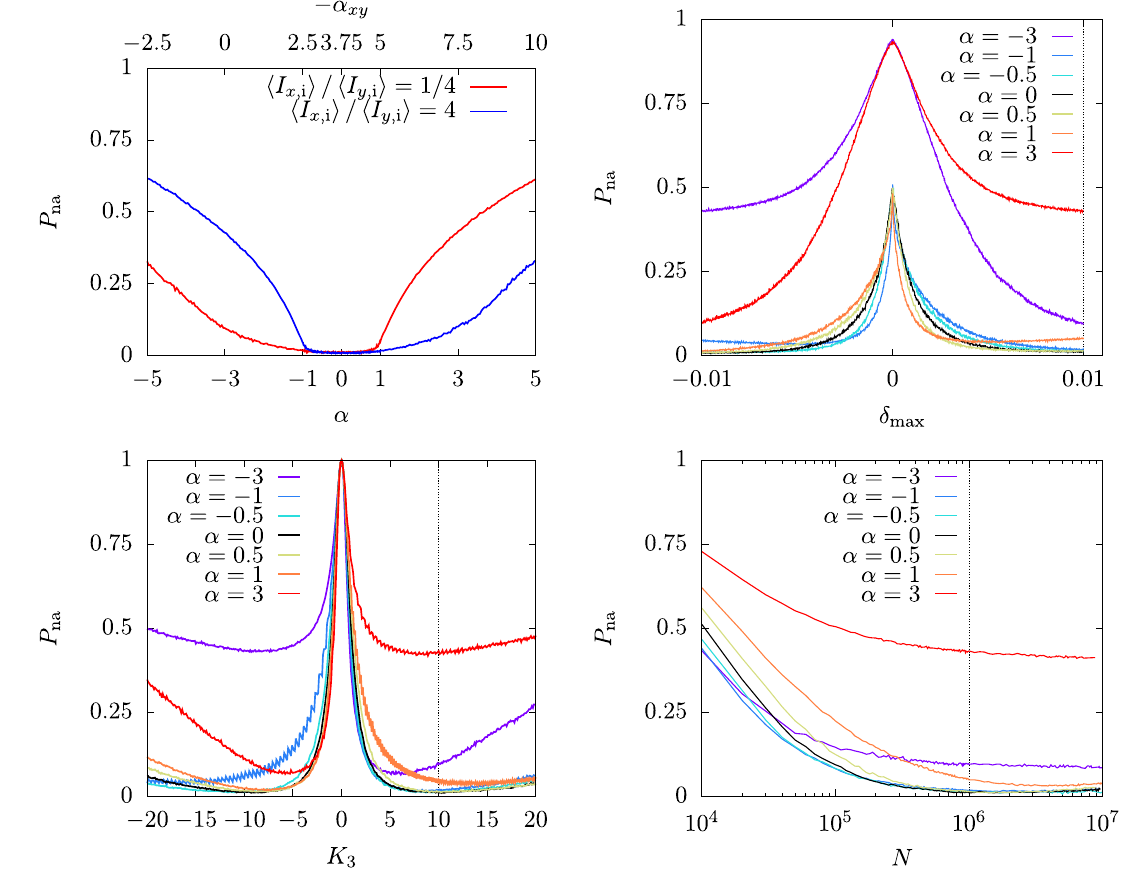
FIG. 7. Simulation results of P as a function of the detuning parameter α for two reciprocal values of the initial emittance ratio (top na left), frequency excursion δ (top right), normal octupole strength K 3 (bottom left), and number of turns N (bottom right). Seven max > ω > ω values of α representing all possible regimes were used. A positive value of δ indicates a process where ω y; x y; f and vice max i < 0 (simulation parameters: ω 2 . 602 , β β 1 , α α 0 , δ 0 . 01 , K 10 , N ¼ 10 6 , N 10 4 versa for δ x ¼ x ¼ y ¼ xx ¼ yy ¼ 3 ¼ p ¼ max max ¼